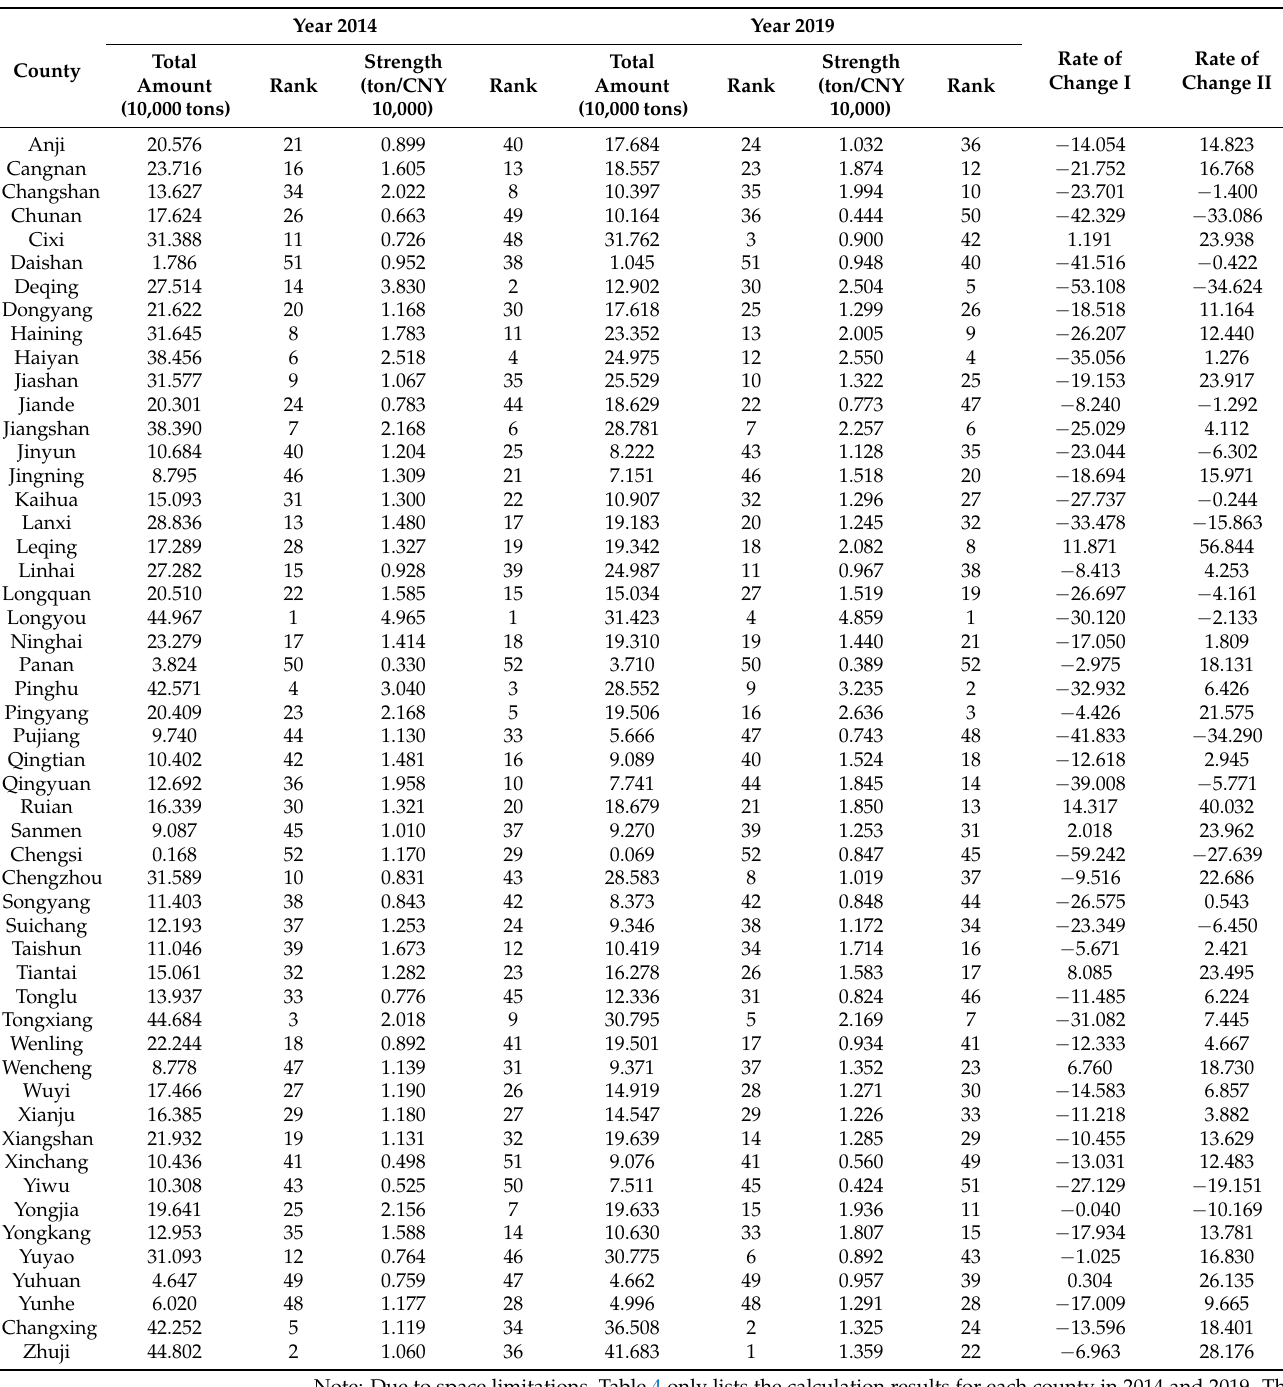
Table 4. Structure and Intensity of Agricultural Greenhouse Gas Emissions and Total Agricultural Greenhouse Gas Emissions in Zhejiang Province from 2014 to